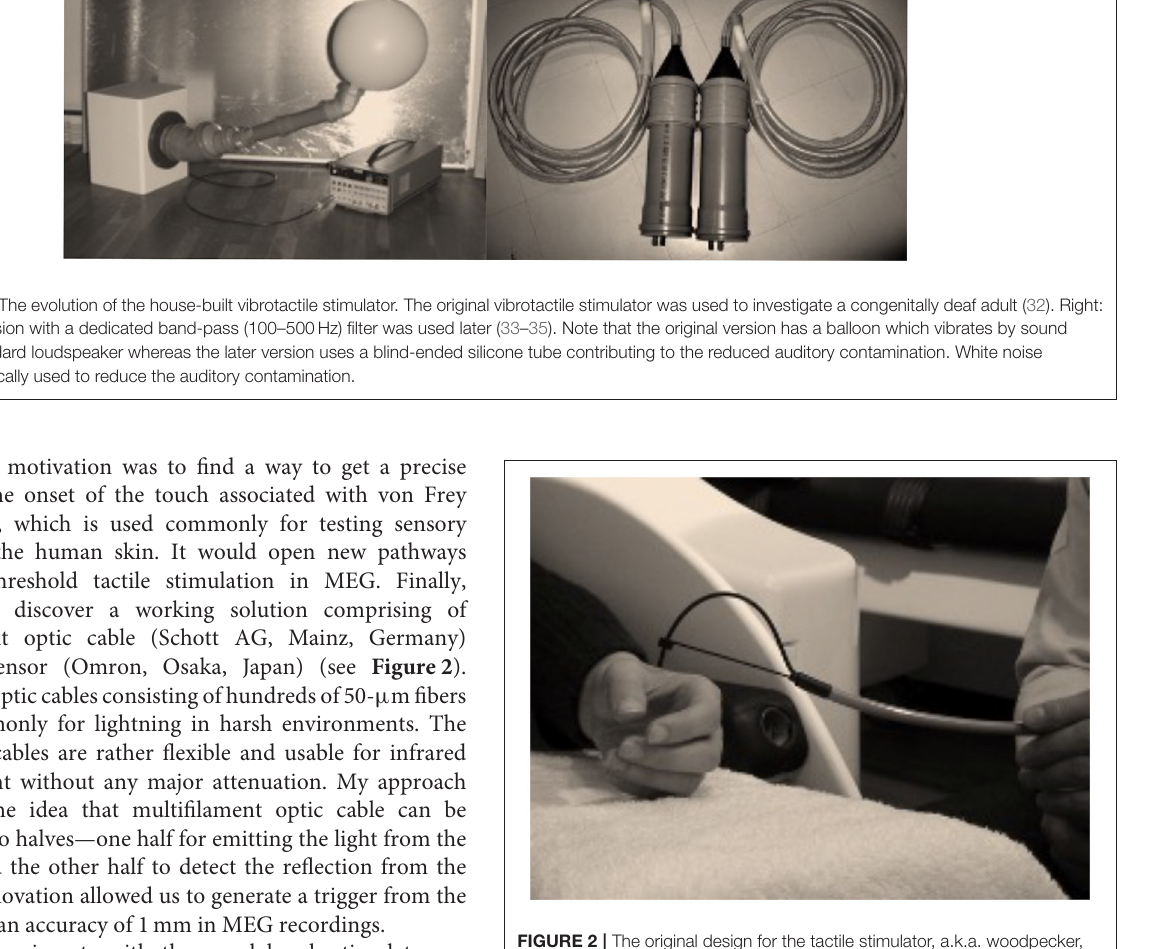
FIGURE 2 | The original design for the tactile stimulator, a.k.a. woodpecker, used in tactile stimulation studiers ( 37, 39) is based on multifilament optical fiber (Schott Spectraflex; Schott AG, Mainz, Germany) and photosensor (Omron, Osaka, Japan). Note that the design of the handle limits the maximum force on the skin similarly as in an aesthesiometer based on von Frey